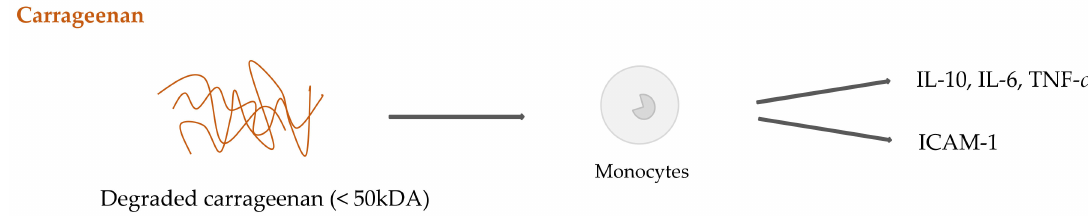
Figure 8. Degraded carrageenan activation of monocytes.